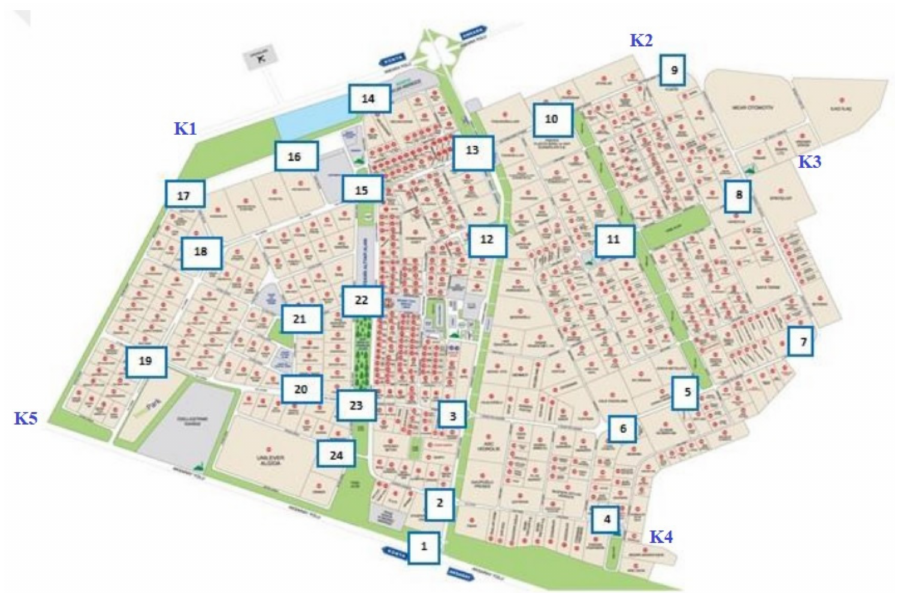
Figure 1. Display of measurement points in the OIZ map (numbering represents sampling points).